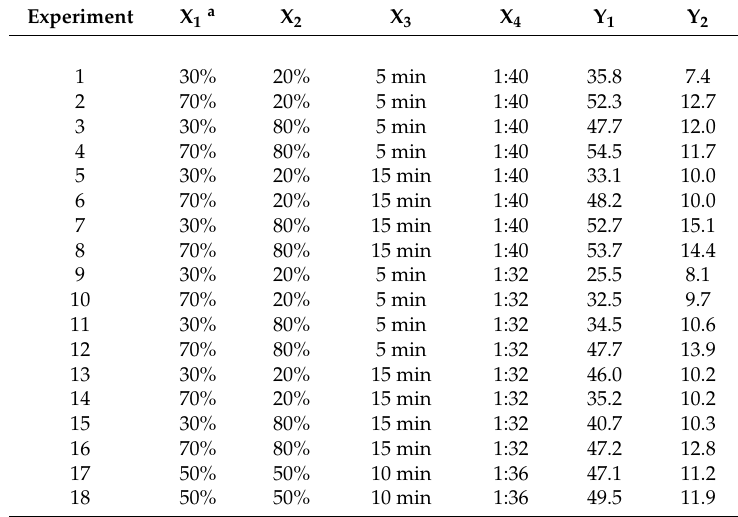
Table 1. The experimental plan of the Factorial Design and the obtained